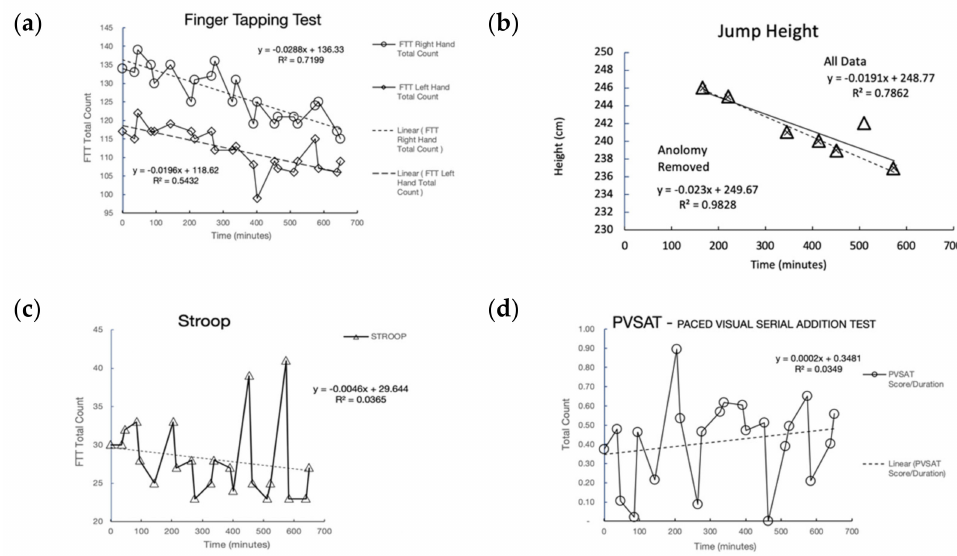
Figure 4. Performance Tests ( a ) FTT, ( b ) Jump Test, ( c ) Stroop, ( d ) PVSAT.